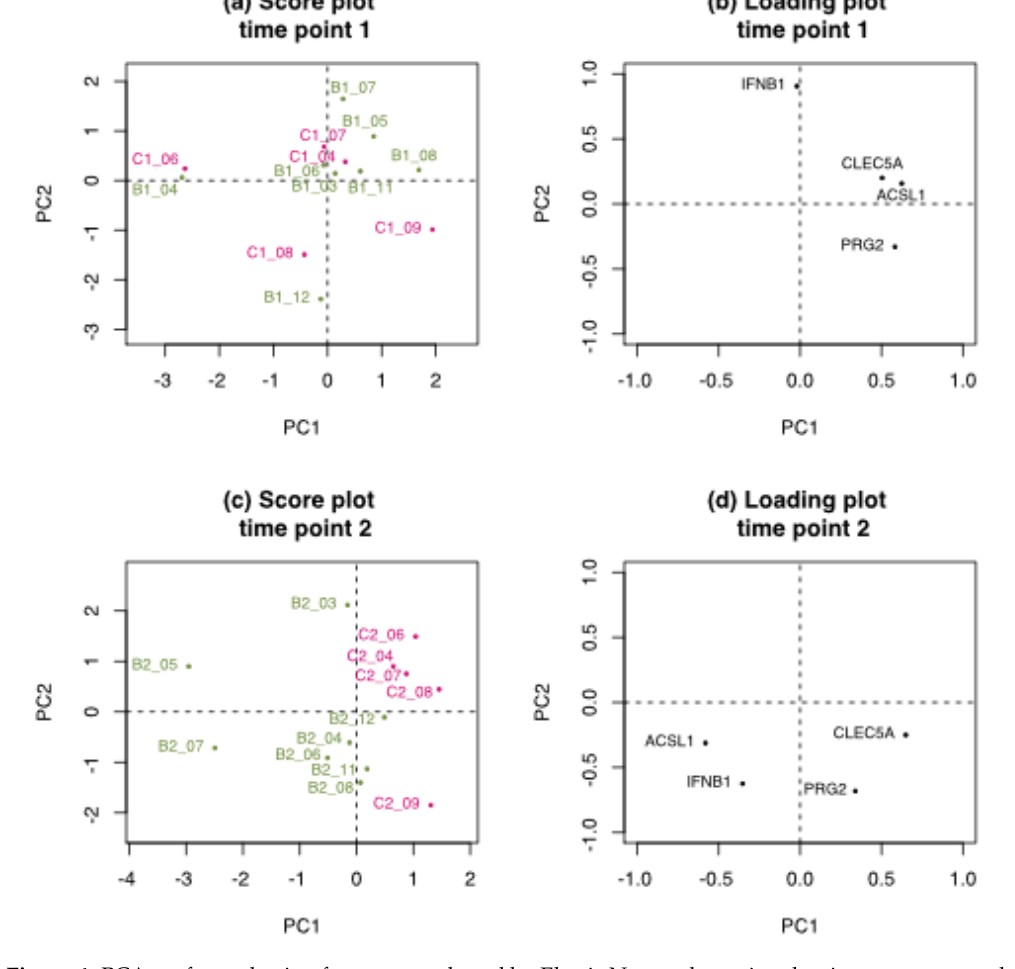
Figure 4. PCA performed using four genes selected by Elastic Net marker using the six genes proposed from “the China benzene exposure study” as markers of Benzene exposure. Each time point was run separately as fold change over time 0, prior exposure. Time point 1 ( a , b ) immediately after 3 days of benzene exposure (post ‐ shift), and time point 2 ( c,d ) one day after recovery(pre ‐ next shift). Scores ( a , c ) of exposed workers (in green), referents (in pink), and corresponding loadings of the genes ( b , d ) .